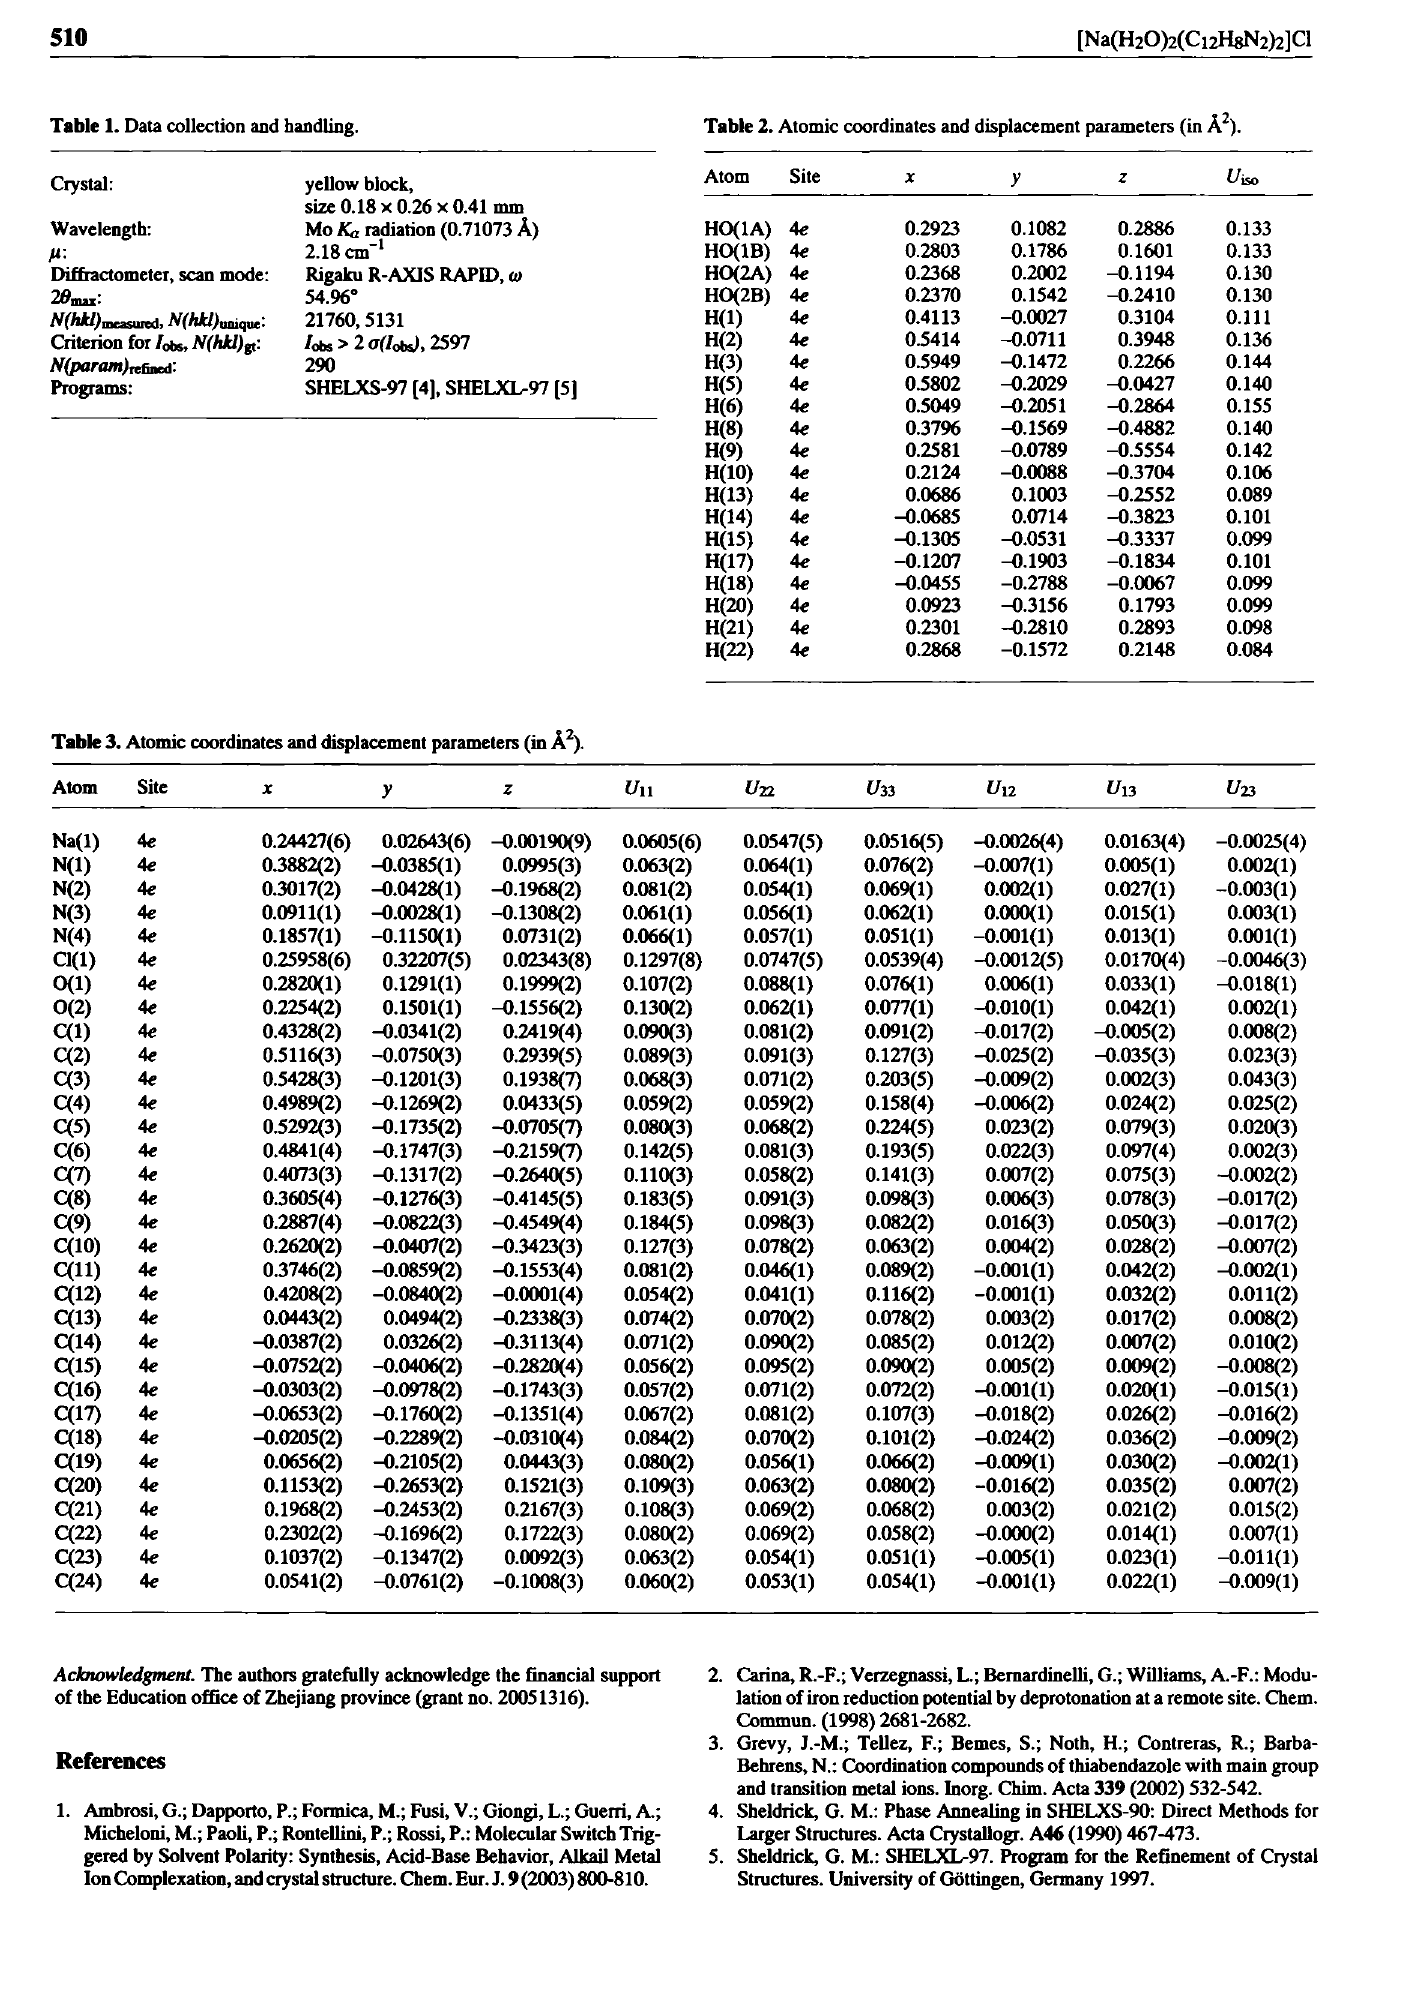
Table 1. Data collection and handling. Table 2. Atomic coordinates and displacement parameters (in Ä 2 ).